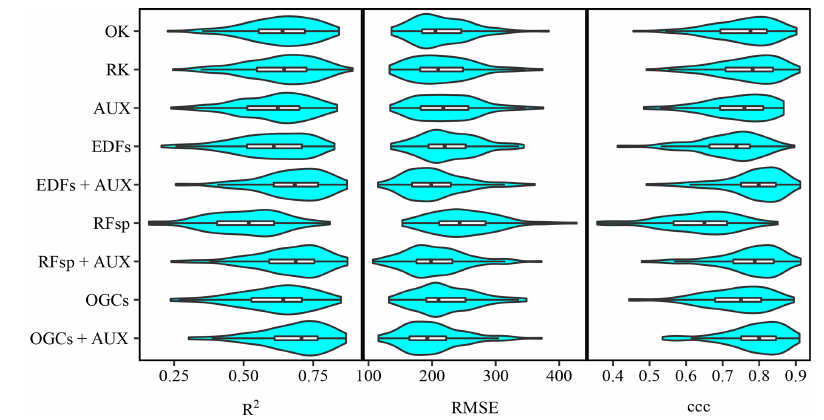
Figure A2. Violin plots showing the accuracies obtained on the meuse dataset (zinc contents) with each method. The plots show values obtained with 100 splits into training and test datasets.